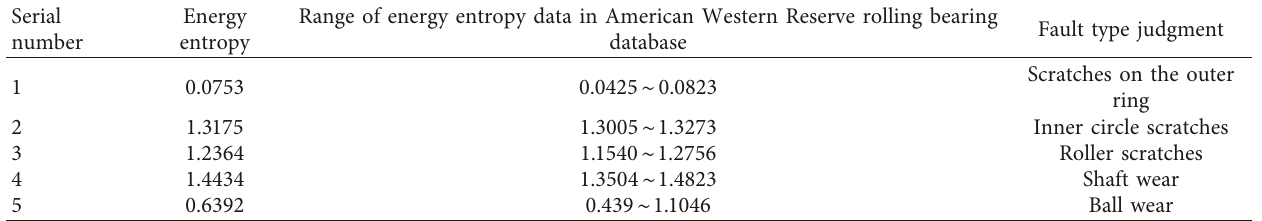
Table 9: Comparison table of fault type